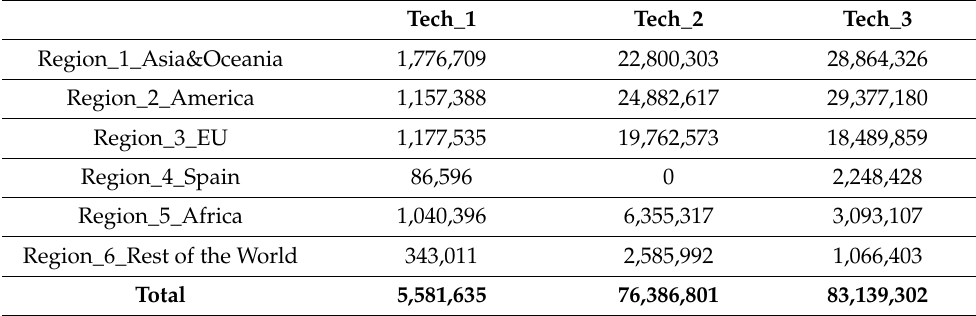
Table 7. Water split 1 account. Solution of x by region and technology (million $).